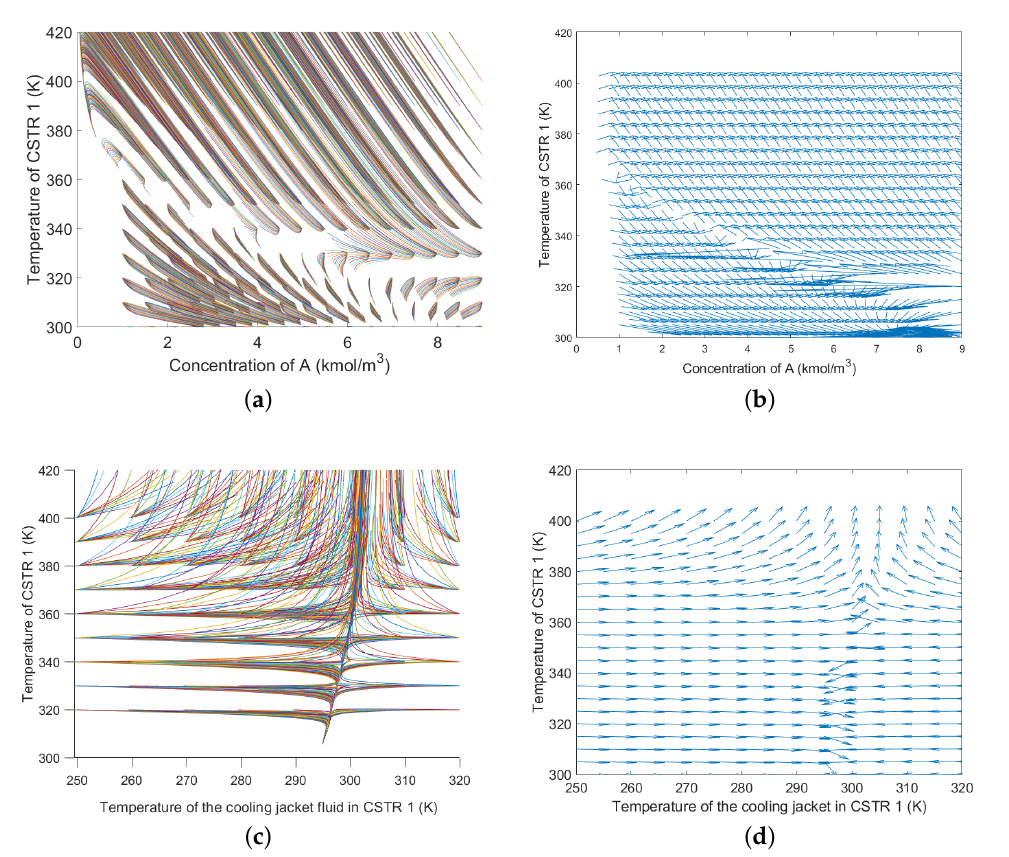
Figure 5. Phase portrait of R 1. ( a ) Trajectories of T R ,1 vs. C A ,1 for T J ,1 = 300K; ( b ) Directions of the trajectories with T J ,1 constant; ( c ) Trajectories of T R ,1 vs. T J ,1 for C A ,1 = 2.1727kmolm − 3 ; ( d ) Directions of the trajectories with C A ,1 constant.